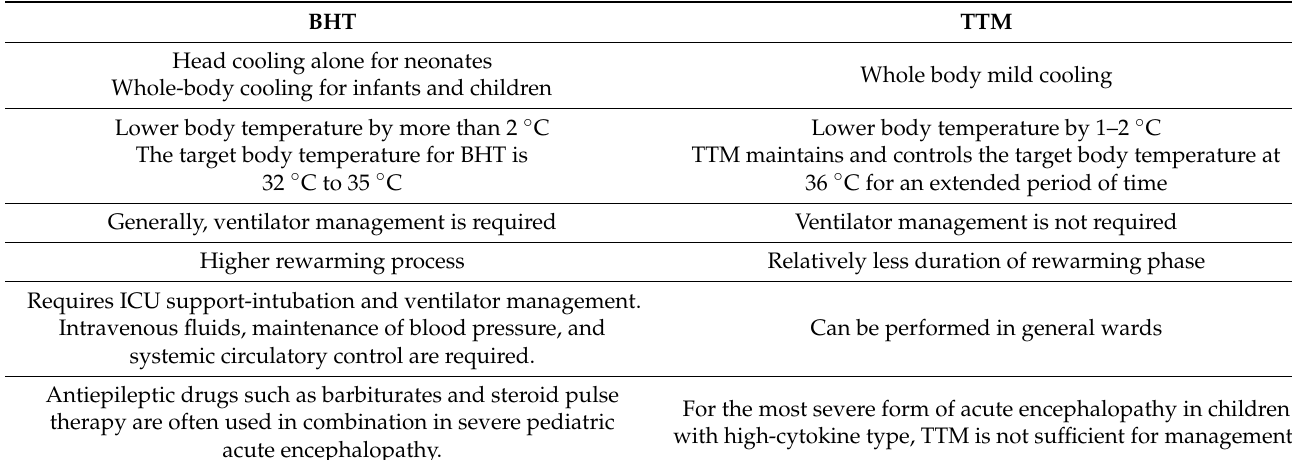
Table 1. Distinguishing between BHT and